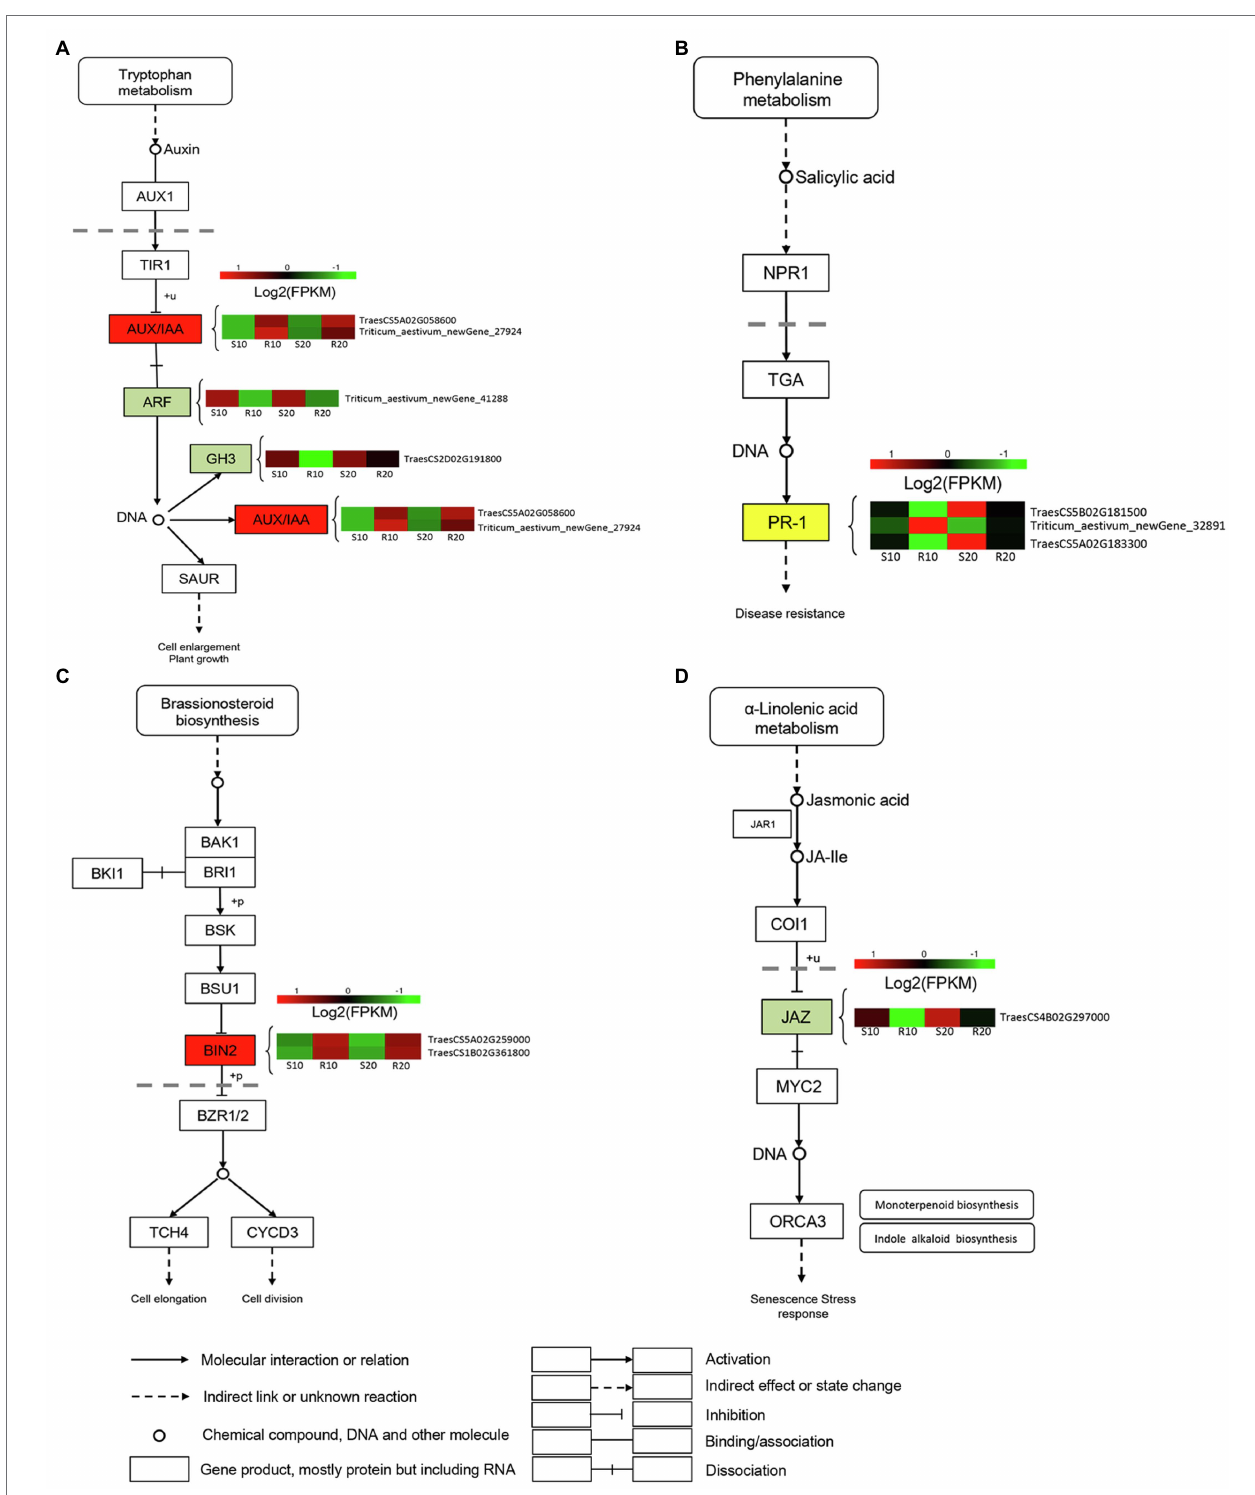
FIGURE 5 | DEGs related to phytohormone signaling transduction pathway. (A) Auxin (AUX); (B) salicylic acid (SA); (C) brassinosteroid (BR); and (D) jasmonic acid (JA). Expression values are presented as log 2 FPKM values (red for upregulated and green for downregulated), and the vertical columns, from left to right, represent S10, R10, S20, and R20. The color of the background indicates the pattern of gene expression: red for upregulation, green for downregulation, and yellow for both upregulation and